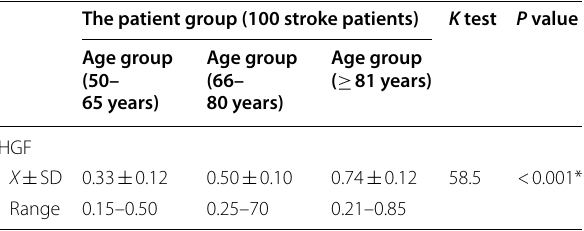
Table 10 HGF concentration in different age groups of stroke